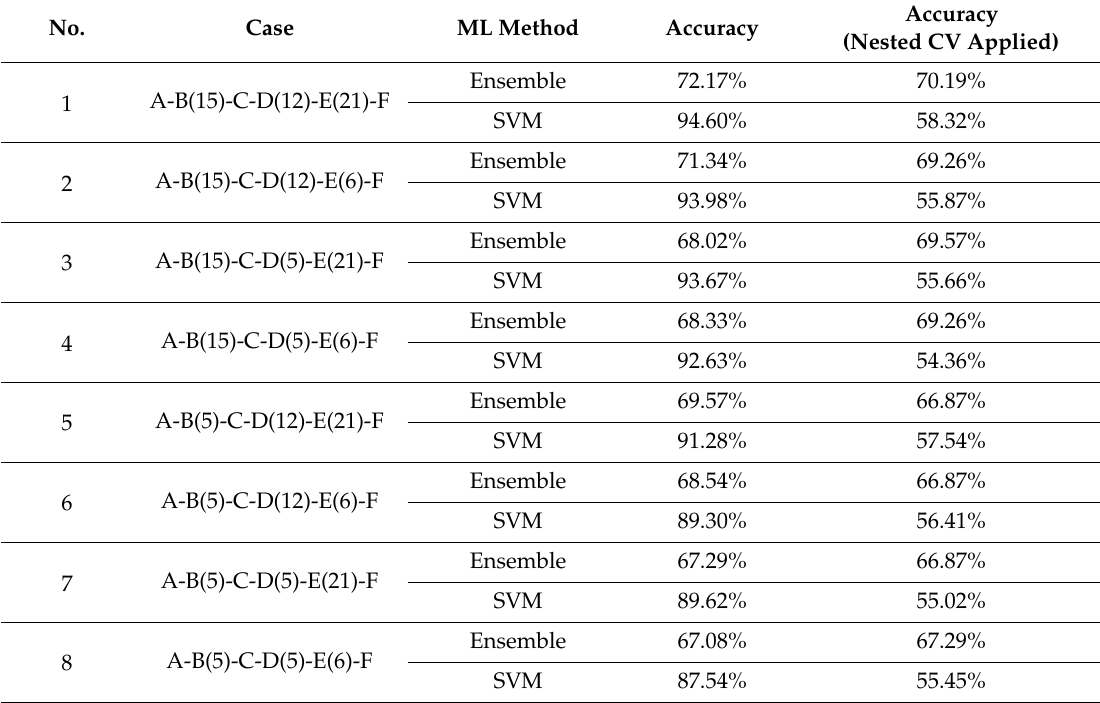
Table 4. Machine Learning (ML) prediction result after the reduction of elements under